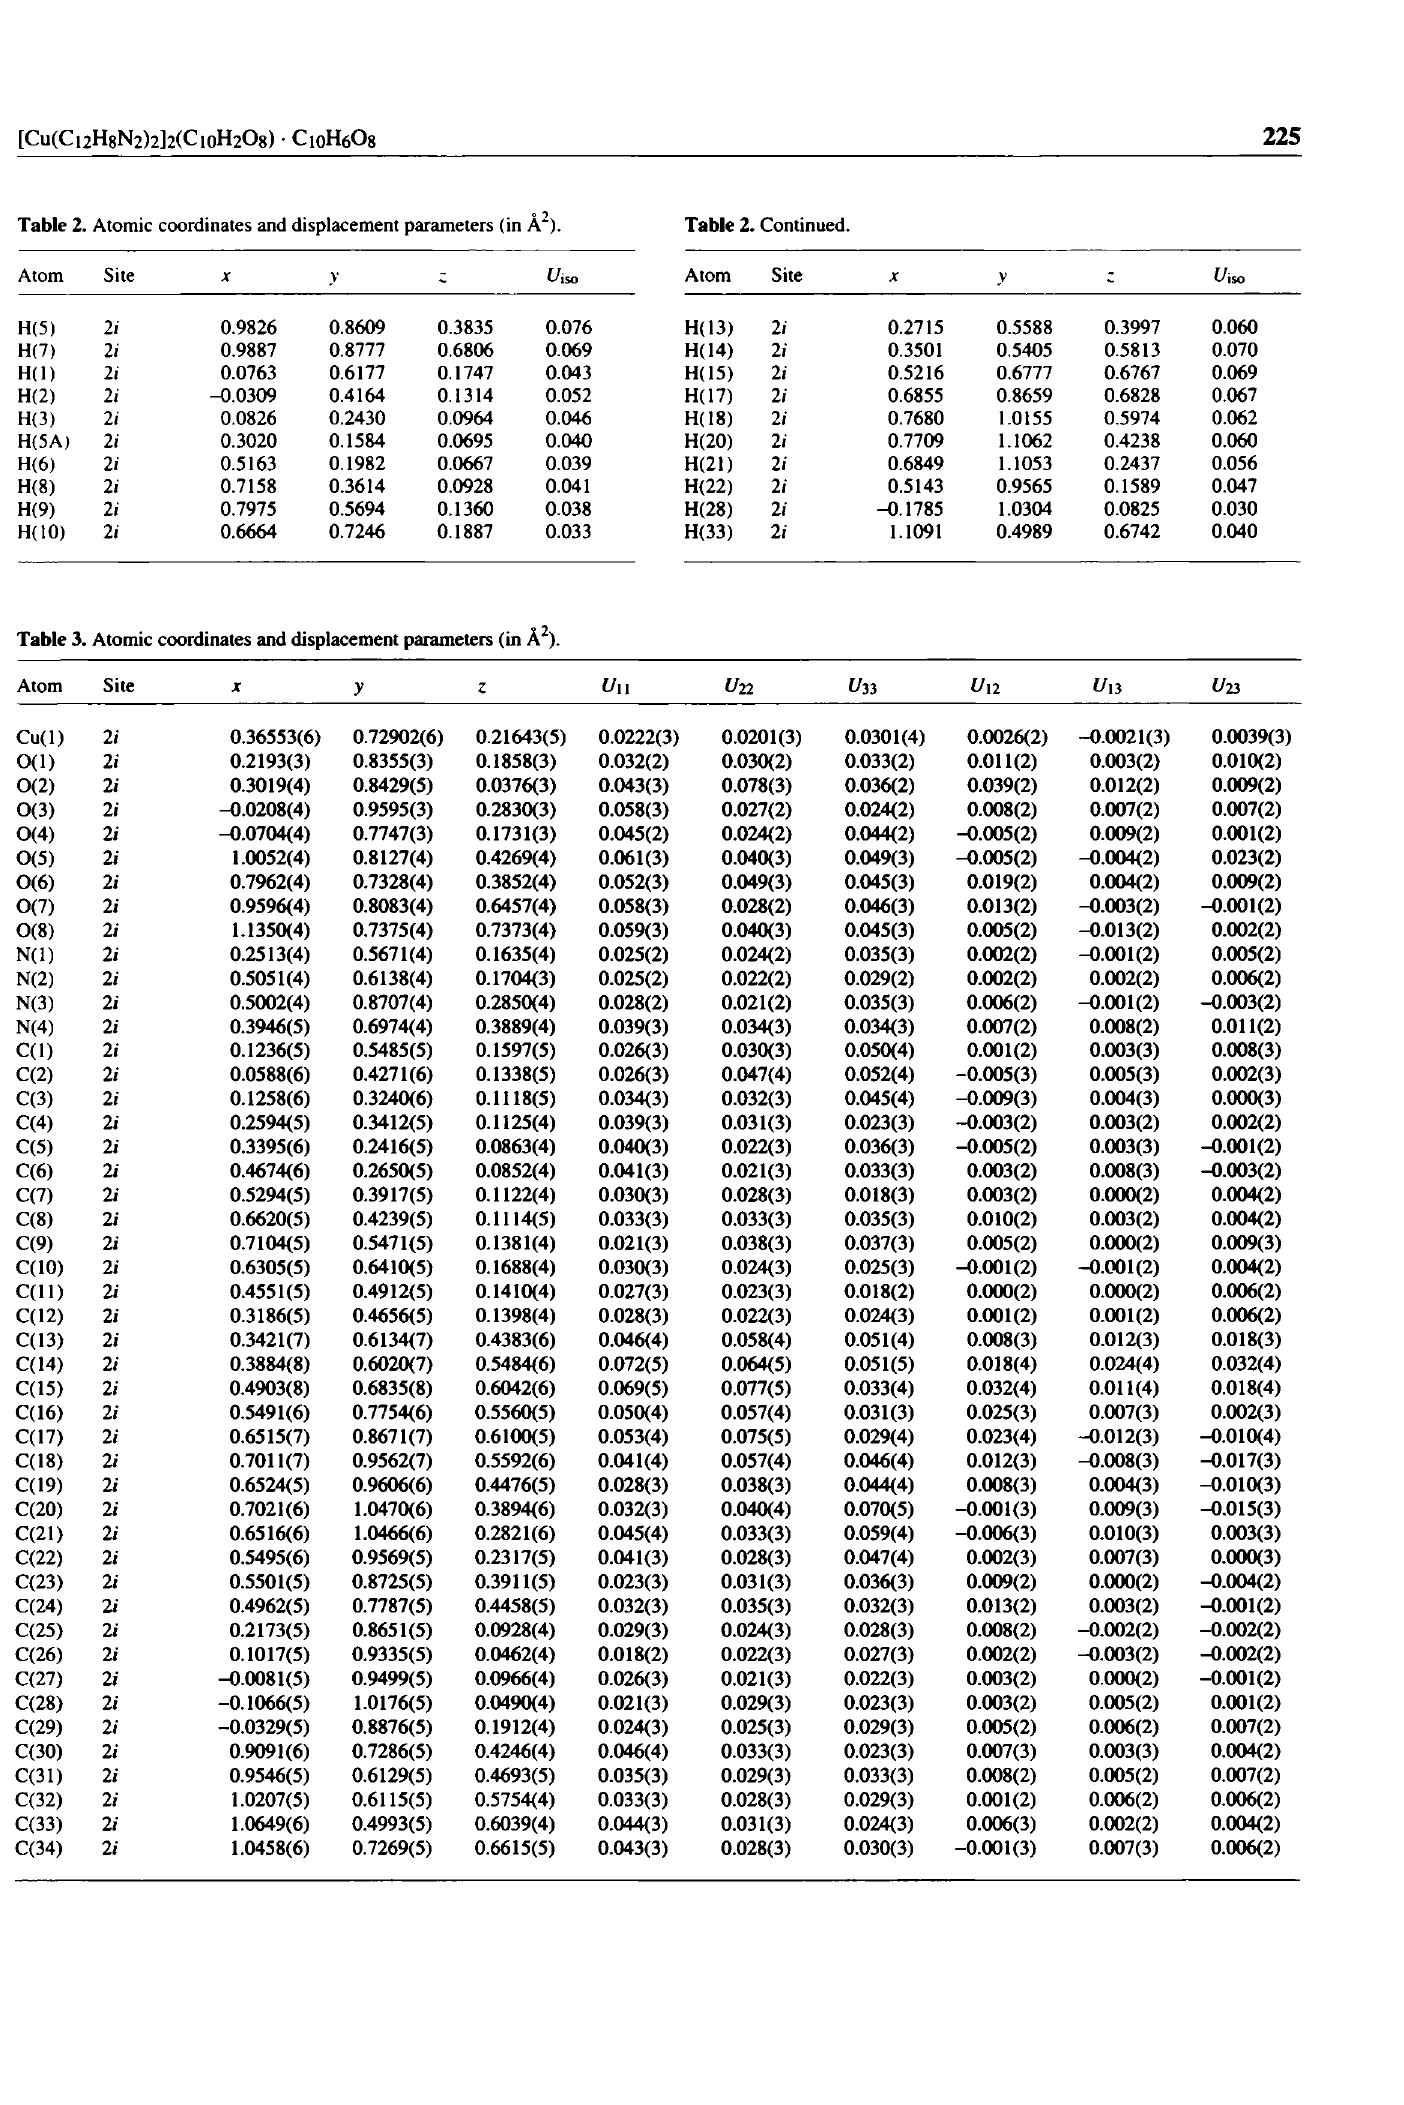
Table 3. Atomic coordinates and displacement parameters (in A 2